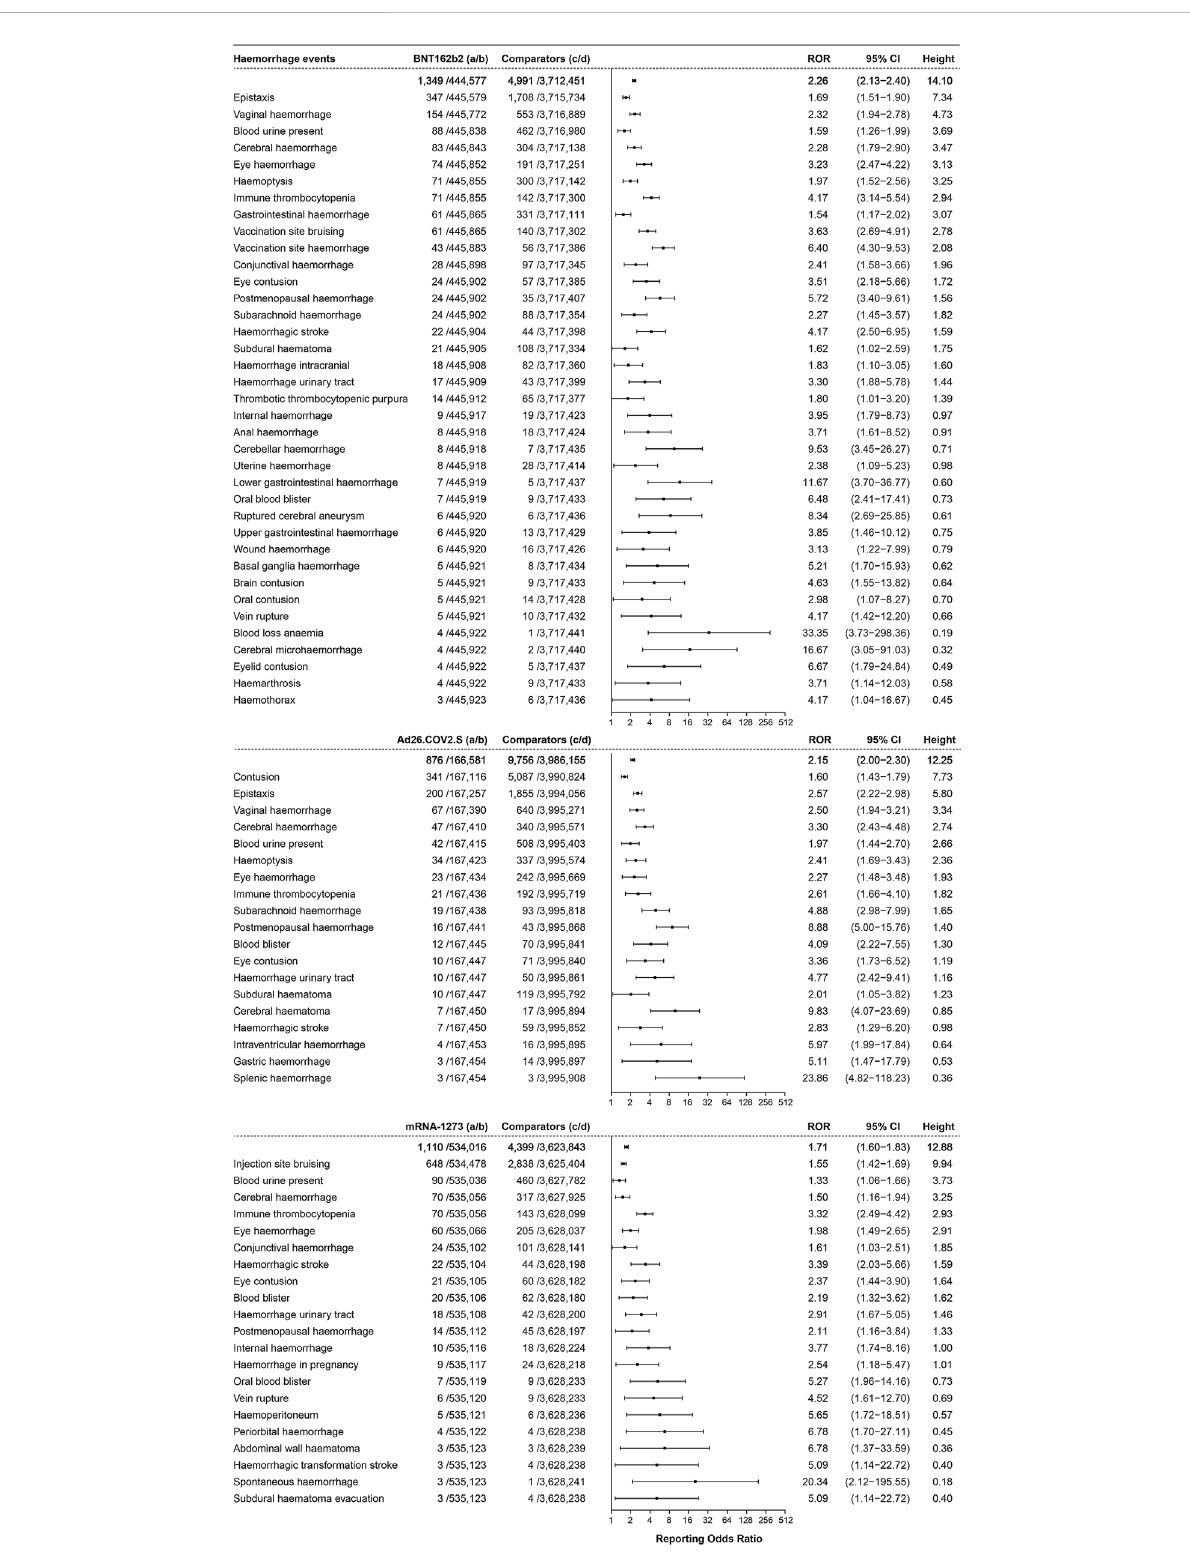
FIGURE 4 ROR values and height of the COVID-19 vaccines of BNT162b2-, Ad26.COV2.S-, and mRNA-1273-associated hemorrhage events. a: cases of target hemorrhage events reported concerning the target COVID-19 vaccines; b: cases of other adverse events reported concerning the target COVID-19 vaccines; c: cases of target hemorrhage events reported concerning all the other vaccines; d: cases of other adverse events reported concerning all the other